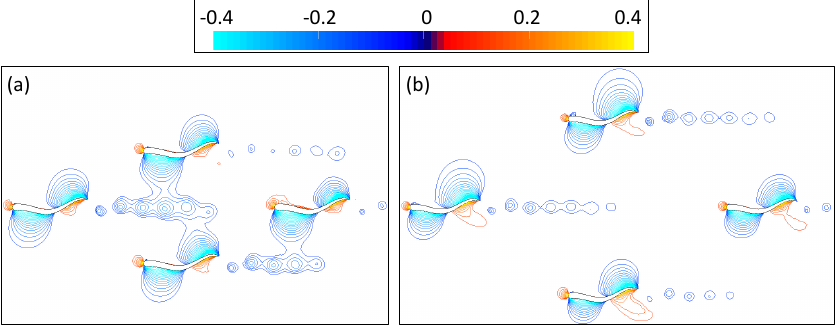
Figure 17. The contours in pressure field of the diamond swarm: ( a ) spacing = 0.75 L , ( b ) spacing = 1.25 L